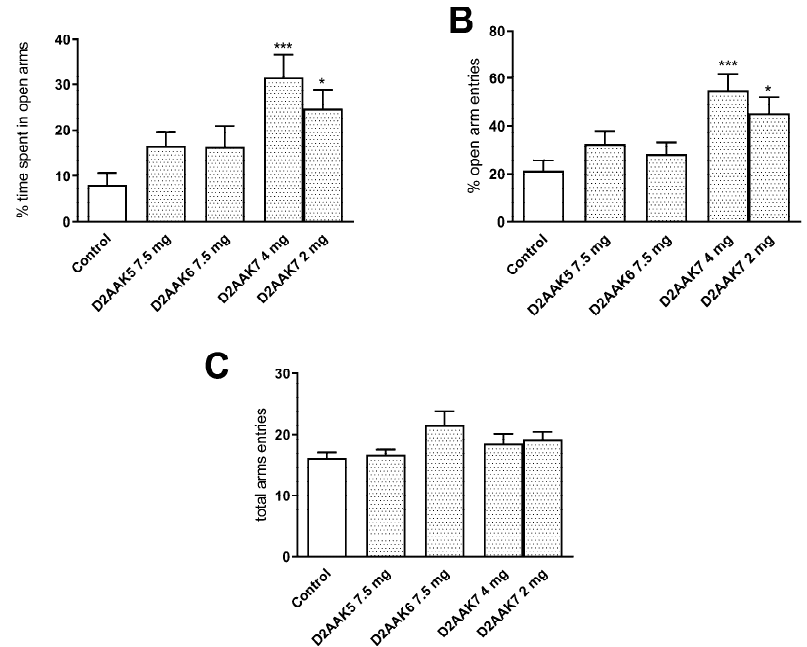
Figure 10. The influence of the investigated compounds D2AAK5, D2AAK6 (7.5 mg/kg), and D2AAK7 (4 and 2 mg/kg) on elevated plus-maze performance in mice–percentage of time spent in open arms ( A ), the percentage of the open arm entries ( B ) and total arm entries ( C ). Investigated compounds were injected i.p. 60 min before the test. The results are expressed as mean ± SEM of the one independent experiment. * p < 0.05; ** p < 0.01; *** p < 0.001; vs. control (Dunnett’s test).